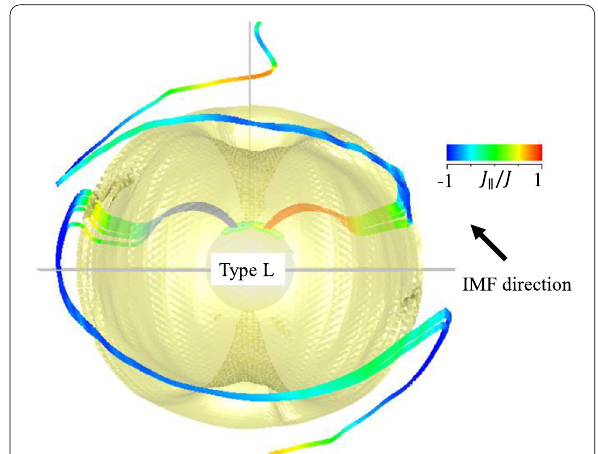
Fig. 5 Overall picture of the type L current system connected to the ionosphere in the northern hemisphere, as seen from the Sun at t 5.5 min. This figure shows the type L current system from the = post-noon ionosphere (the same as that in Fig. 3) and that from the pre-noon ionosphere. The type L current from the pre-noon ionosphere goes to the magnetosheath in the southern hemisphere. The 3D equi-contour of the pressure seen from the Sun is shown with volume rendering. The equi-contour roughly indicates the magnetopause. The black arrow in the right indicates IMF direction